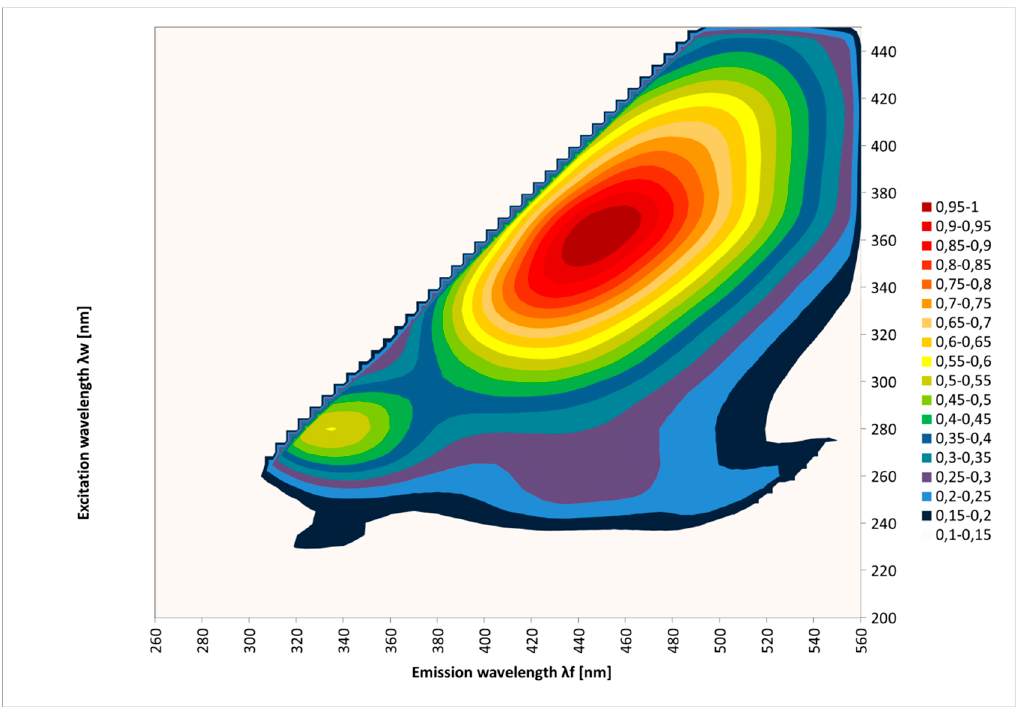
Figure 1. Excitation emission (EEM) spectra of di ff erent botanical origins of honey ( a –acacia, b –phacelia, c –buckwheat, d –lime, e –multifloral, f –rape, g –dandelion, h –honeydew, and i –goldenrods). Source: own research.